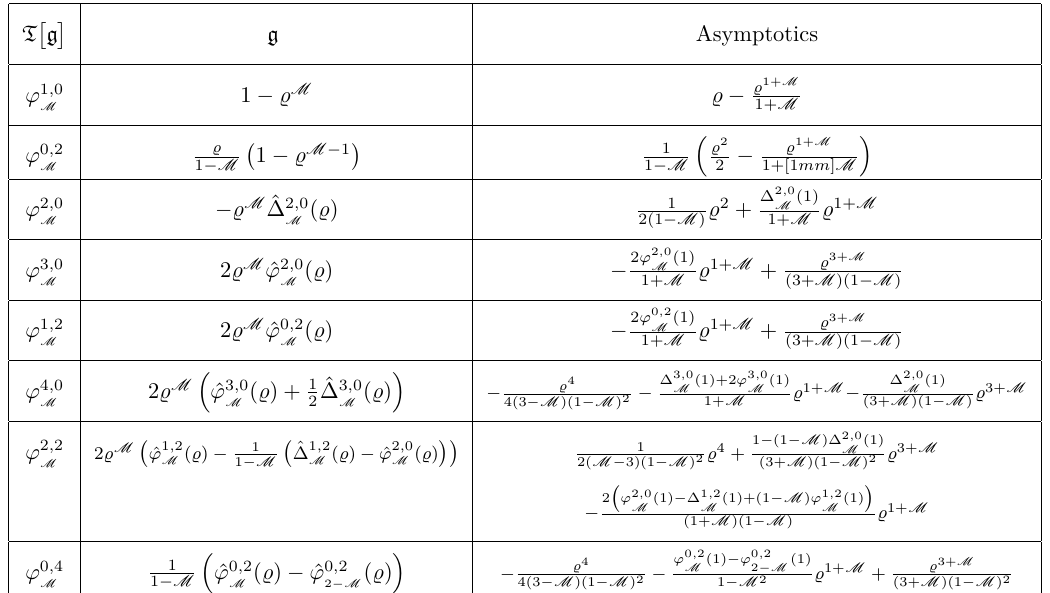
Table 1 . The functions appearing in the gradient expansion of the Markovian ϕ fourth order in gradients, given in the form of an integral transform defined in eq. (B.14). We also present the leading asymptotic behaviour of the functions which is used for computing boundary